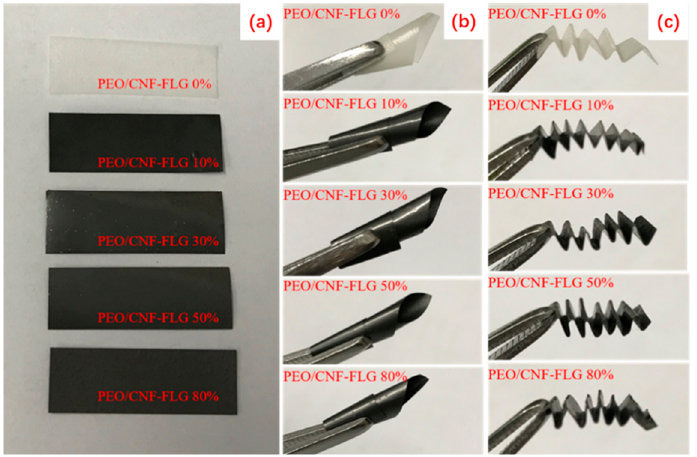
Figure 6. Digital photos of PEO/CNFs-FLG composite films under different deformations: flat ( a ); twist ( b ); fold ( c ).